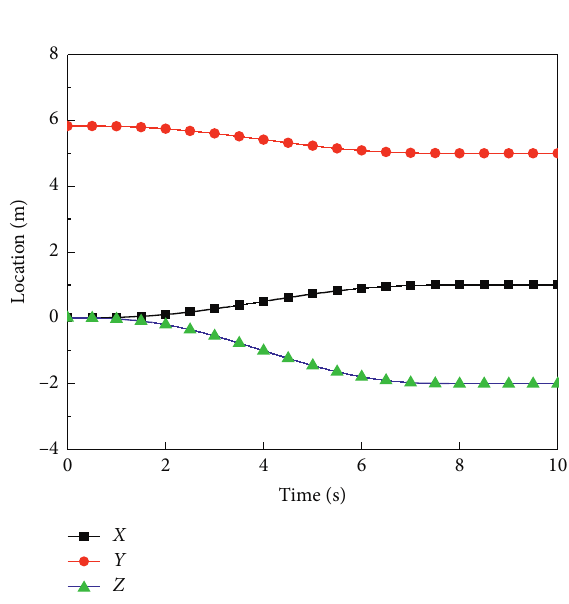
Figure 3: Terminal location planning